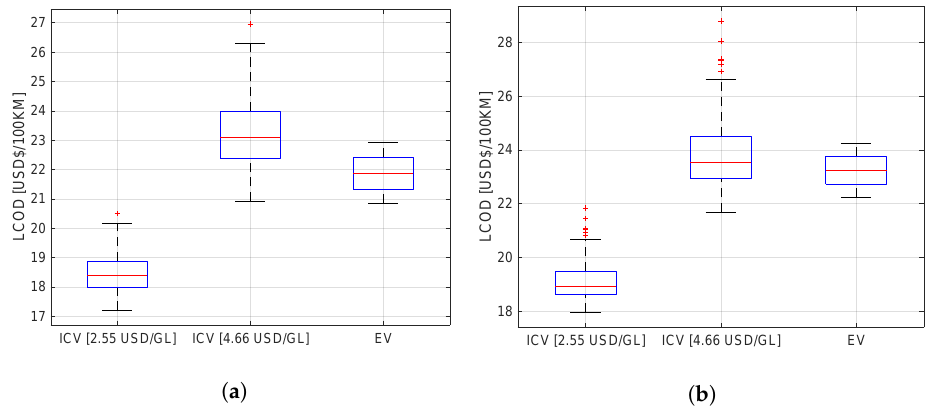
Figure 2. Sensibility Analysis with respect to Vehicle Performance. Note that the red horizontal line represents the median, whereas the blue lines show the highest and lowest quartile. ( a ) Case A ( r = 10%). ( b ) Case B ( r = 12%).